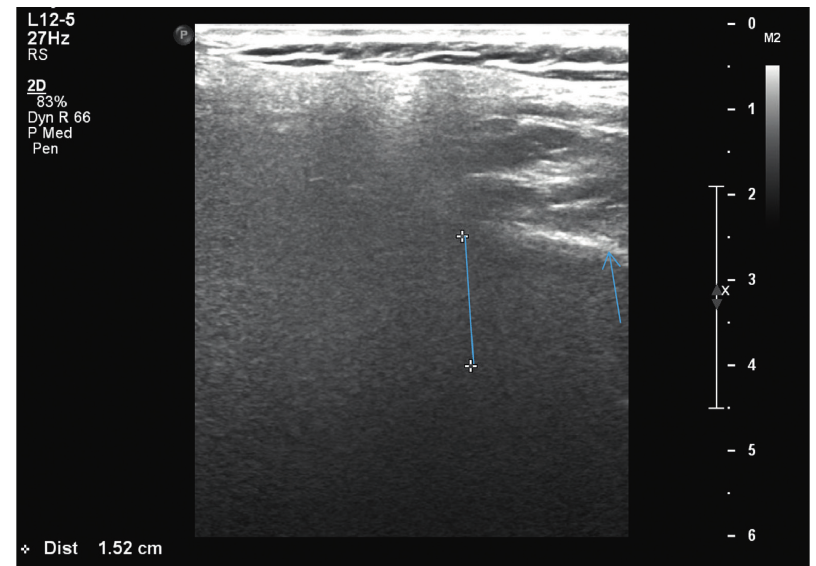
Figure 4: Right parotid gland with measurement of depth distal to mandible of patient with HbA1c